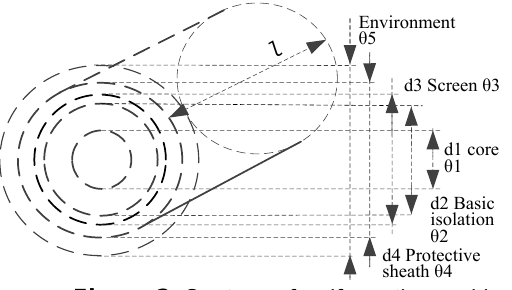
Figure 2 . System of uniform thermal bodies